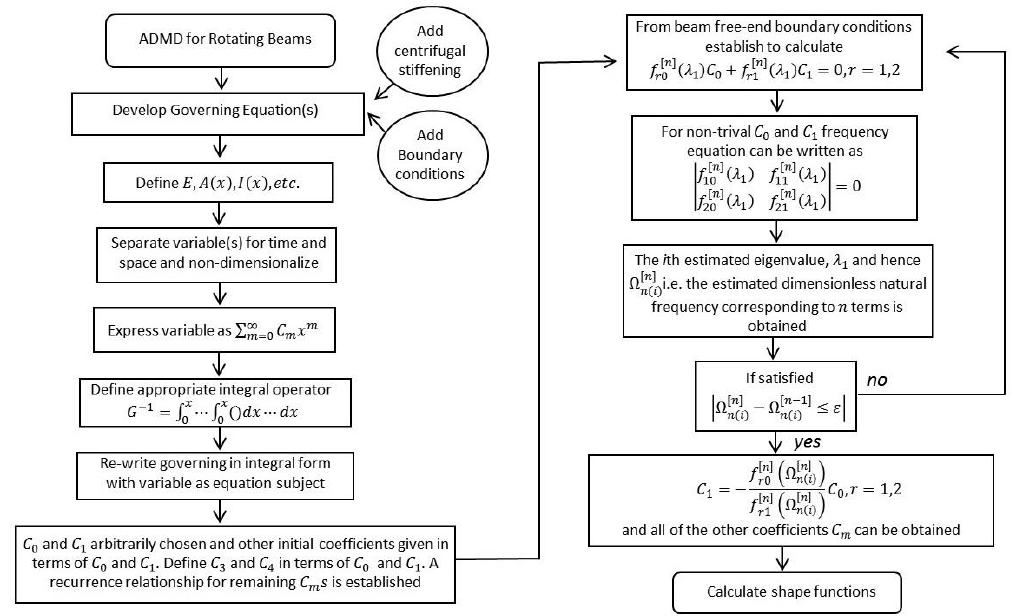
Figure A1. Flowchart showing the main steps of the Adomain modified decomposition method.